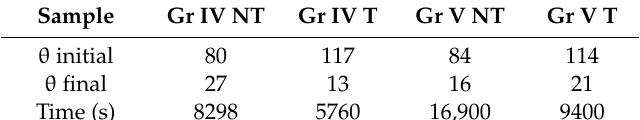
Figure 12. Progression of water contact angle regarding UV irradiation time on the grade IV and grade V original samples.